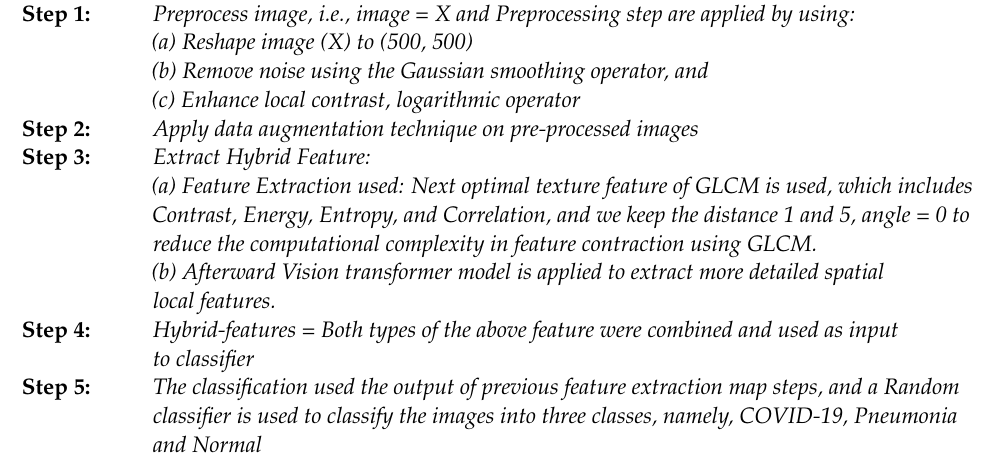
Algorithm 1: Classification of chest disease by using hybrid features and random forest classifier